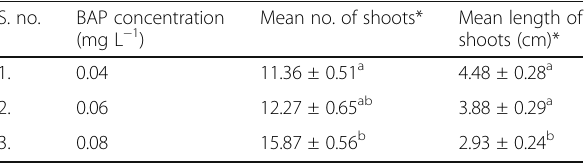
Values represent mean ± SE *Twenty replicates per treatment, repeated thrice. One-way ANOVA with Duncan ’ s multiple range test was applied Data in columns followed by different letter (superscript) significantly different at 0.05 %